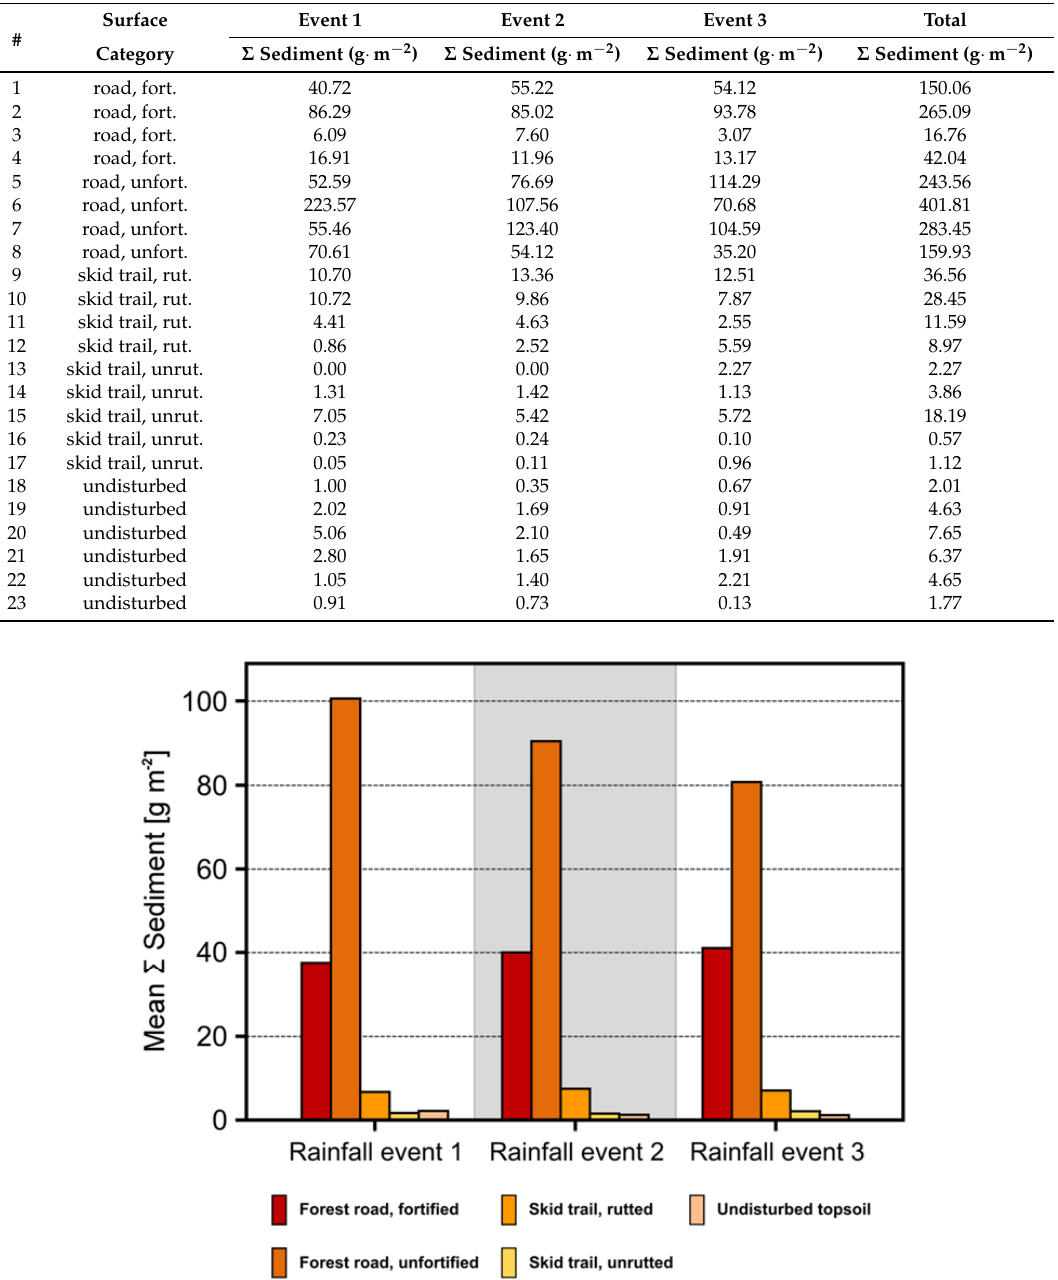
Table 8. Eroded sediment sums for each simulation.